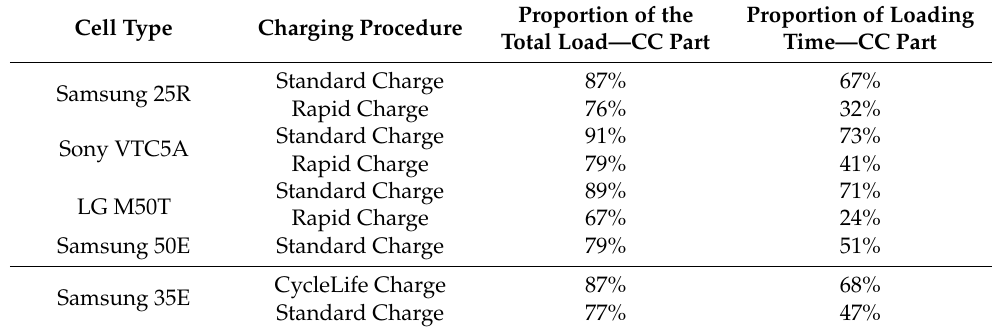
Table 5. Proportion of the total load and loading time of the CC part after 500 cycles. Table 7. Proportion of the total load and loading time of the CC part after 900